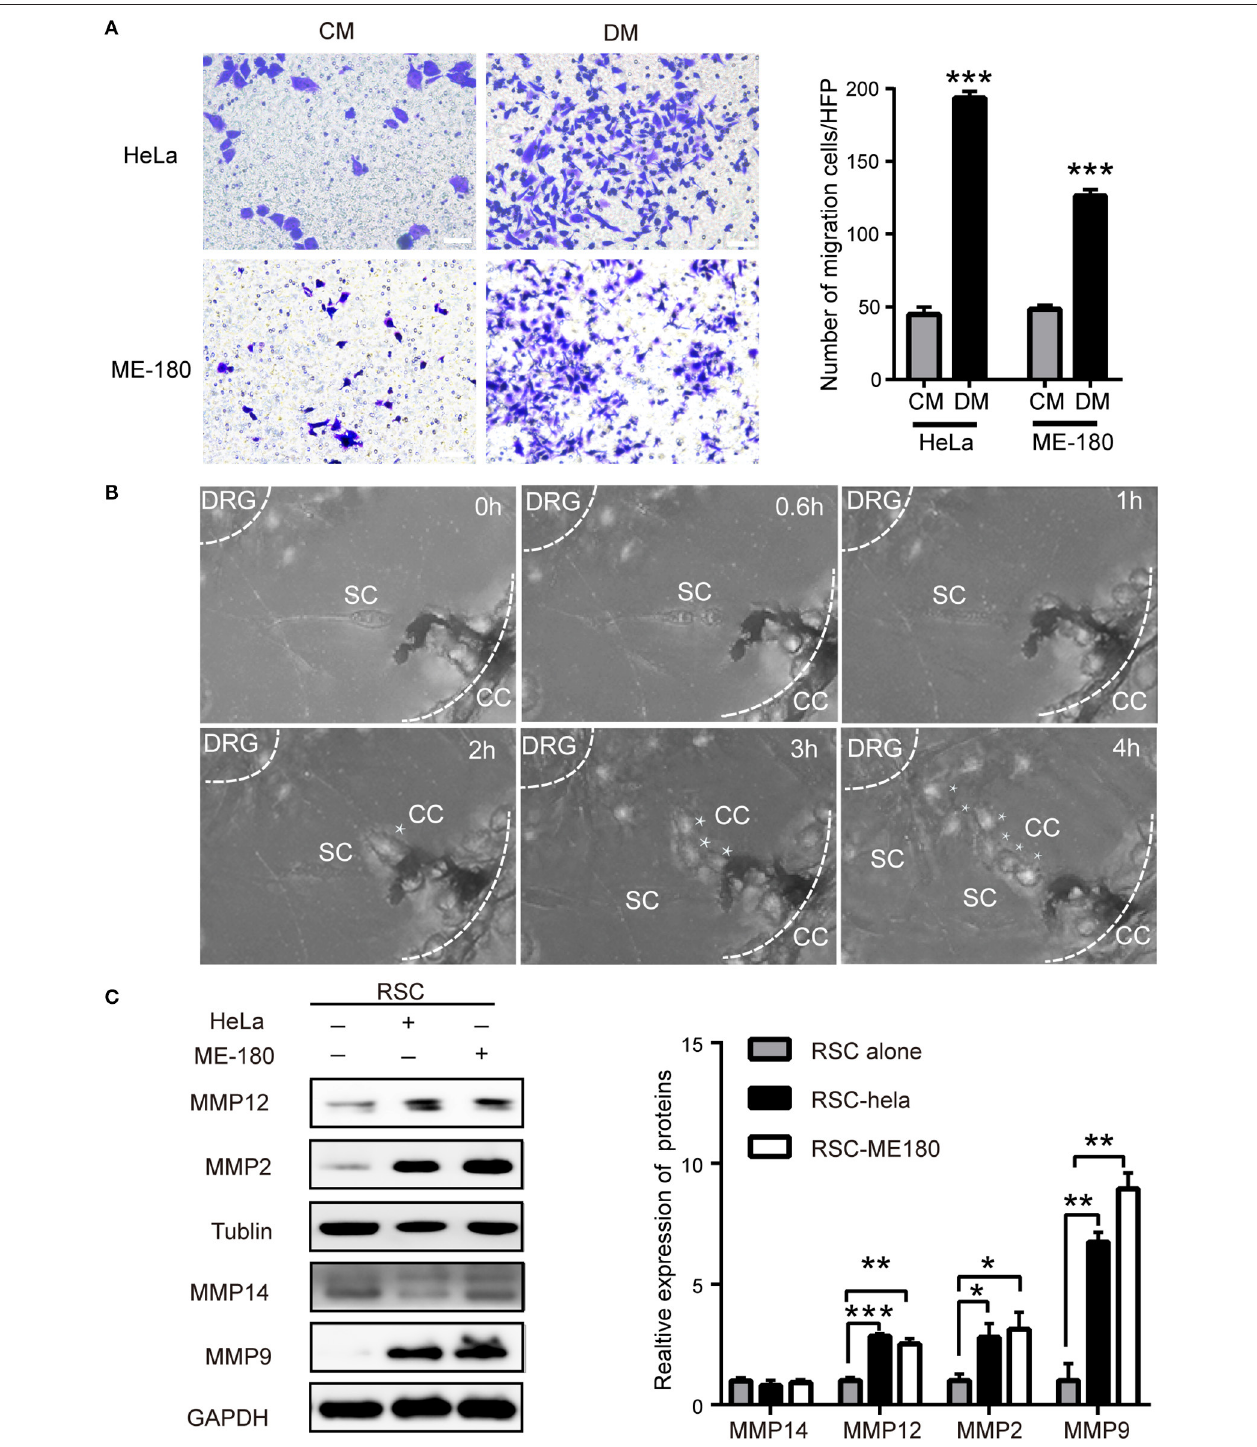
FIGURE 2 | The crosstalk between SCs and cervical cancer cells. (A) DM promotes cell migration of HeLa and ME-180 cells compared with CM. DM, DRG medium; CM, Control medium. ( B) Cocultivation of DRGs with HeLa cells. Images from confocal microscopy shows the process of a cancer cell (marked by asterisks) toward the center of the DRG. Assume that the time of the first picture is 0h. The SCs are marked by white arrows. The smaller white dotted lines describe the border of the DRG and the larger defines the Matrigel edge. (C) HeLa and ME-180 cells upregulated the expression of MMP2/9/12 in SCs. * P < 0.05, ** P < 0.01, *** P < 0.001.